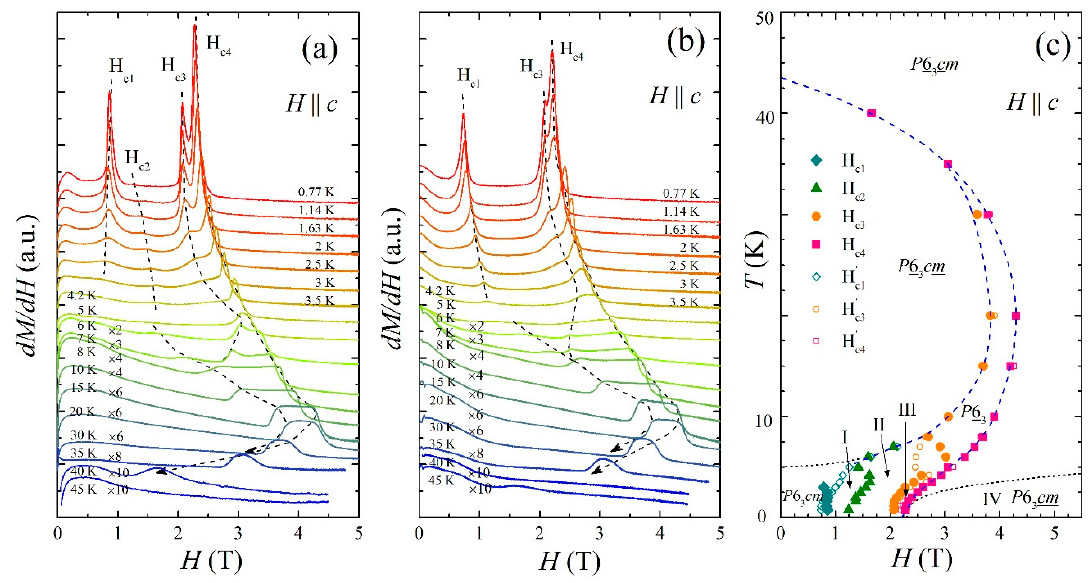
Figure 4. d M / d H curves for H // c measured from 45 to 0.77 K. For clarity, the data for increasing and decreasing fields are shown in ( a ) and ( b ), respectively. Dashed lines are guided for eyes. ( c ) The resulting H - T phase diagram for H // c . Phases I-III are the result in this work, while phase IV and the phase boundaries (dotted lines) show the result obtained in Ref. [8]. The hysteresis effect is observed between phase II and the P 6 3 phase. The change of magnetic symmetry is discussed in the text.